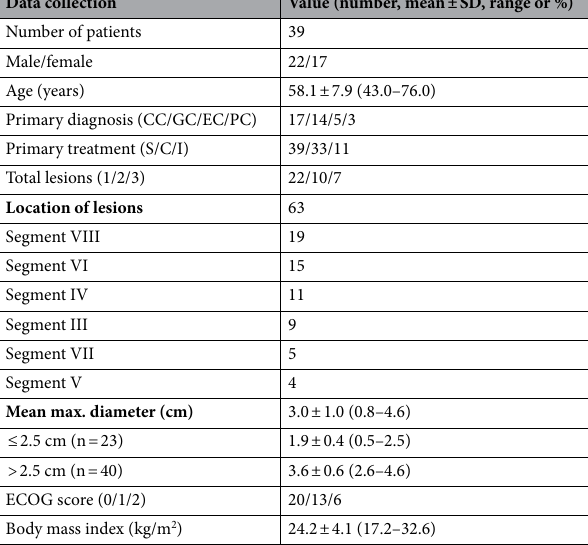
Table 1. Patient characteristics. SD: standard deviation; S: surgery; C: chemotherapy; I: Immunotherapy; CC: colorectal cancer; GC: gastric cancer; EC: esophageal cancer; PC: pancreatic cancer.